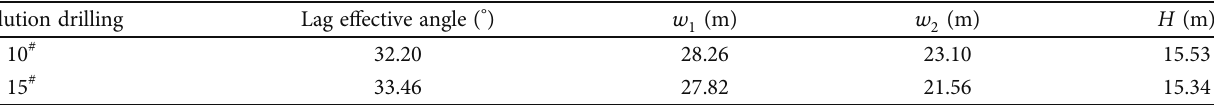
Table 2: Calculation results of ordinary high-level drilling.